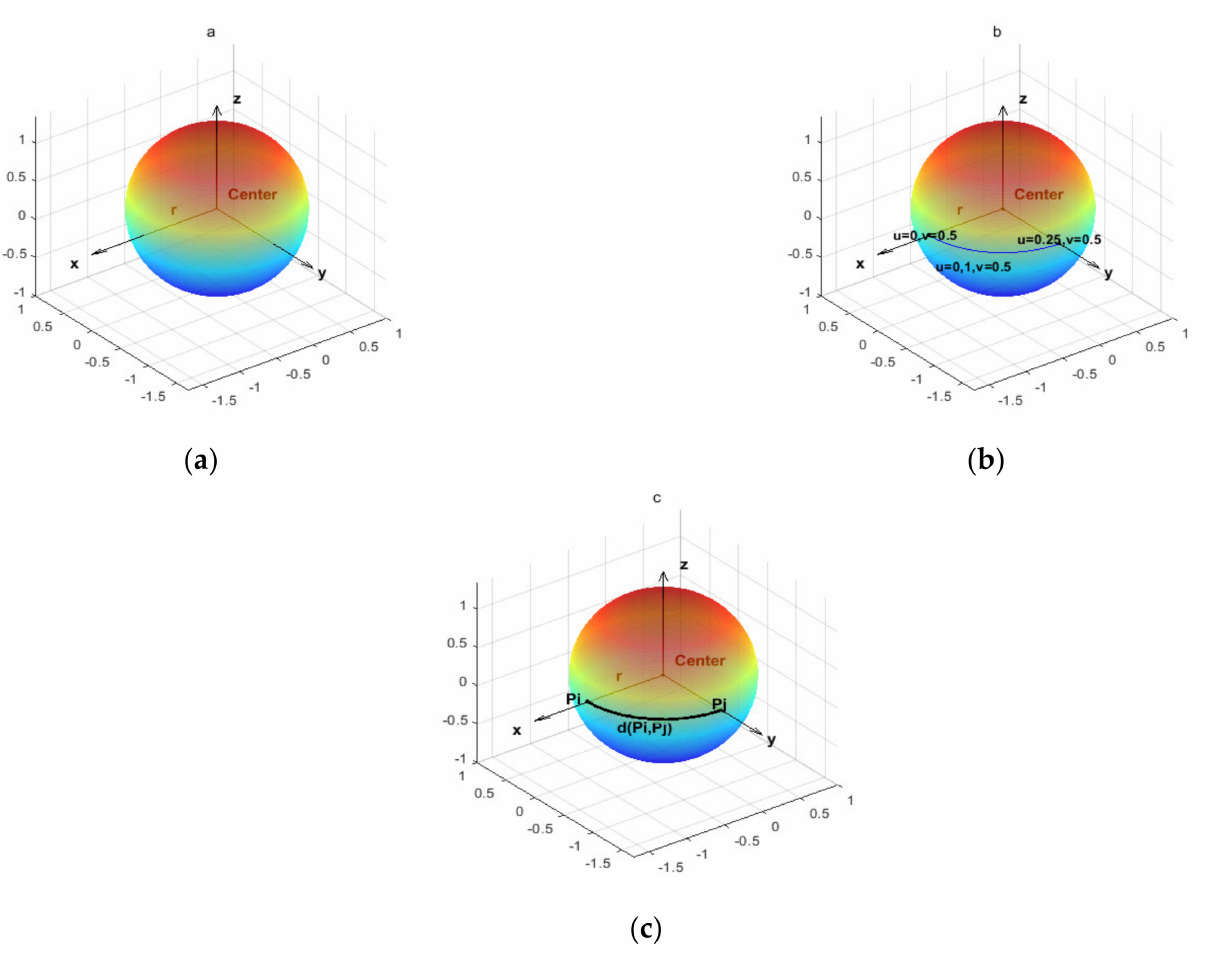
Figure 1. ( a ) represents the geometric definition of the sphere; ( b ) represents the definition of points on the sphere; ( c ) represents the geodesics between two points on the sphere, and the colors represents the height